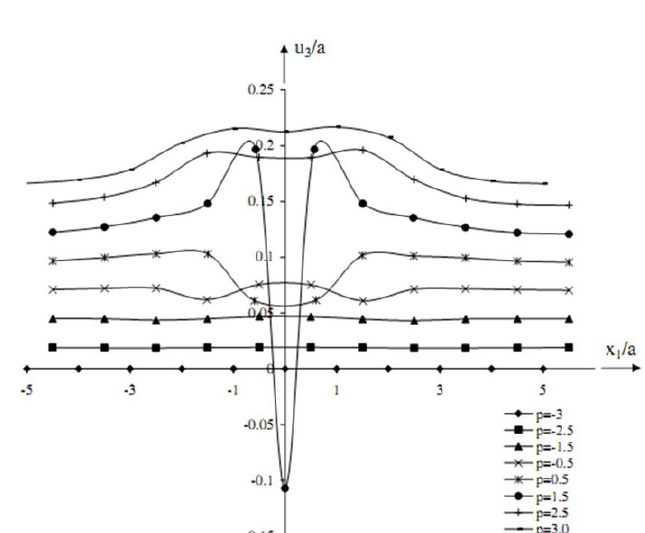
L = 4 a it is found that the nearest neighbors of the Al doped atom move away from the dopant. It is also observed that the displacements of the upper neighbors, atoms labeled 2 and 3 are larger than the displacements of the atoms numbered 5 and 4, respectively. Atoms 2 and 3 are within the upper half of the film, whereas atoms 5 and 4 are in the lower half. For the case of L = 2 a , the relative displacements of the atoms 2 and